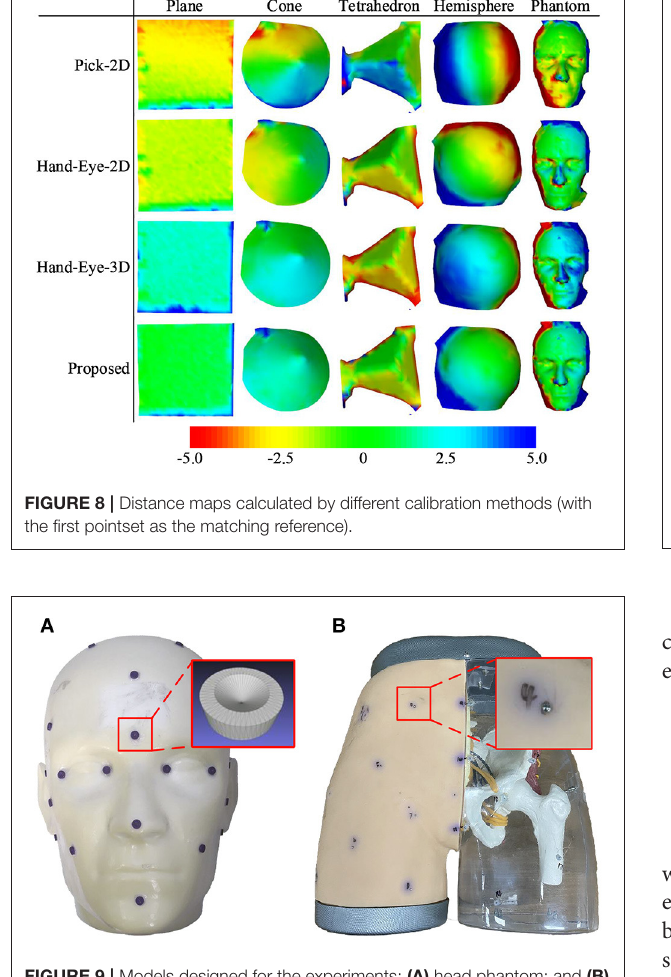
the skin pointset of the phantom extracted from the CT image; (2) PTS target : the skin pointset of the phantom captured by the 3D scanner; (3) T NDI : the spatial transformation matrix to Marker the world coordinate system of the optical marker fixed on the 3D scanner; (4) P i : the fiducials picked from the CT image virtual of the phantom; and (5) P i : the fiducials picked from the real real world by the optically tracked pointer. The point index in the fiducial points is represented by i . The captured pointsets were transformed into the world coordinate system and can be